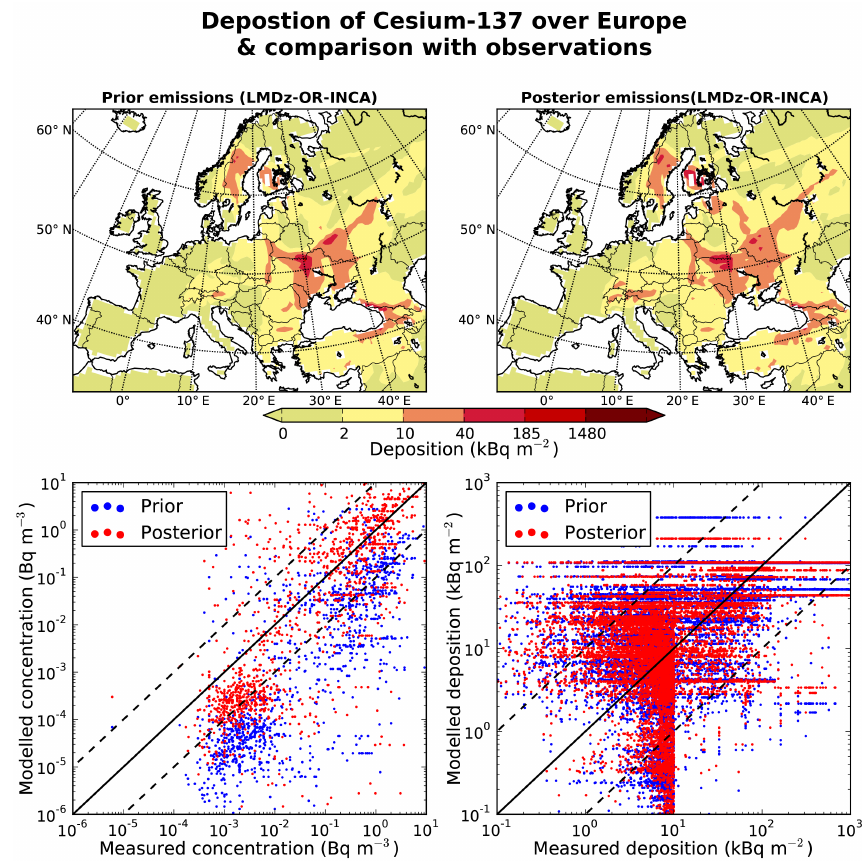
Figure 10. Deposition of 137 Cs using the Eulerian LMDz-OR-INCA chemistry transport model prior emissions from the ensemble of six a priori releases and the optimized emissions resulting from our inversion. Comparison of modeled surface concentrations and depositions of 137 Cs with observations from a recently published data set (Evangeliou et al.,